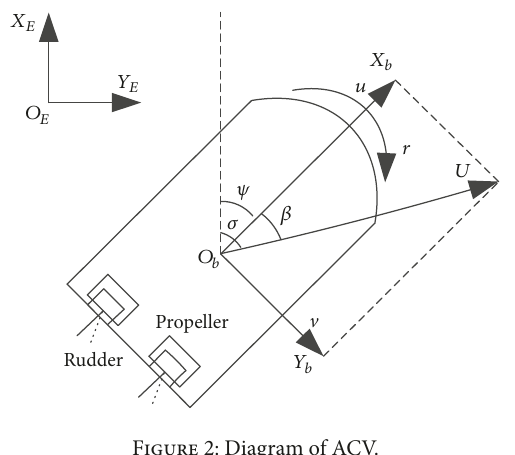
Figure 2: Diagram of